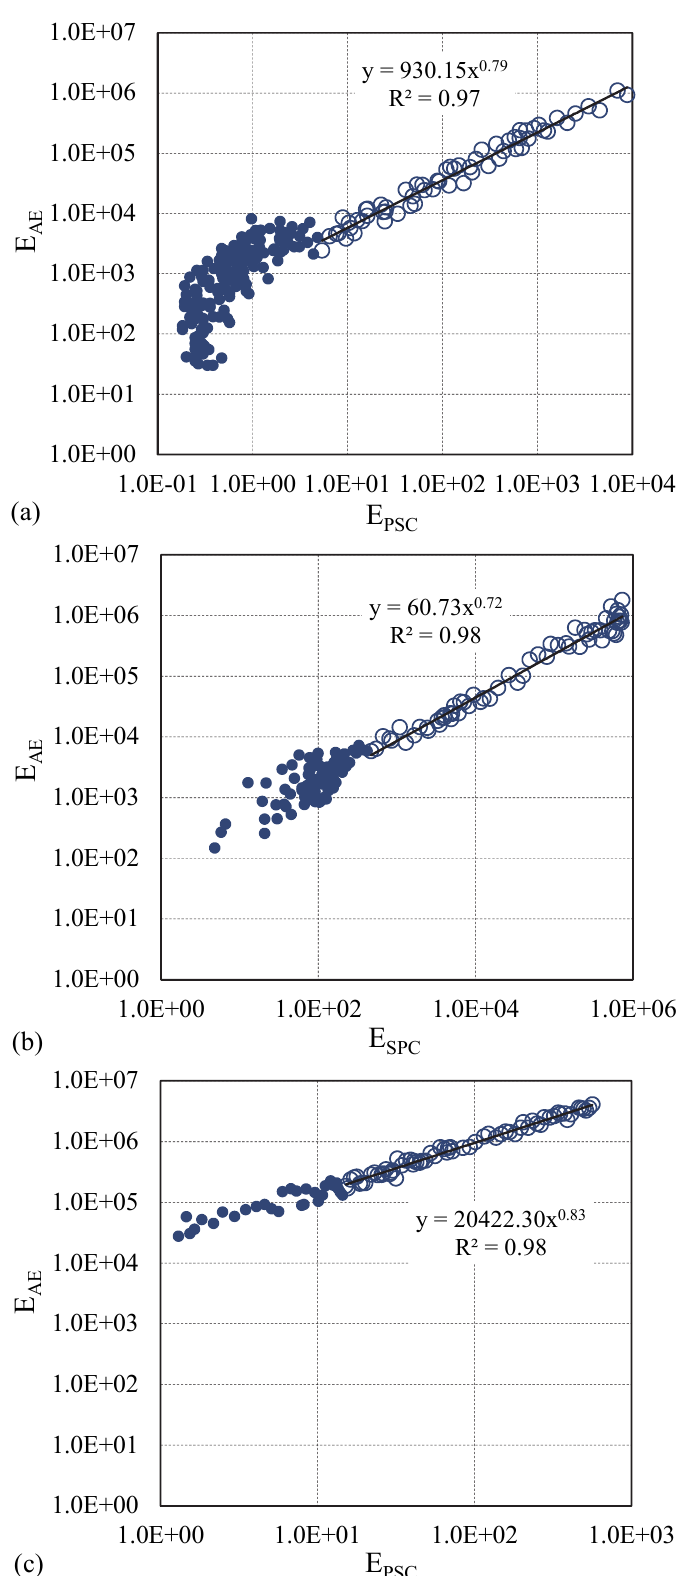
Figure 6: The correlation of the energy calculated by both PSC and AE techniques for a typical specimen of (a) marble, (b) mortar and (c)